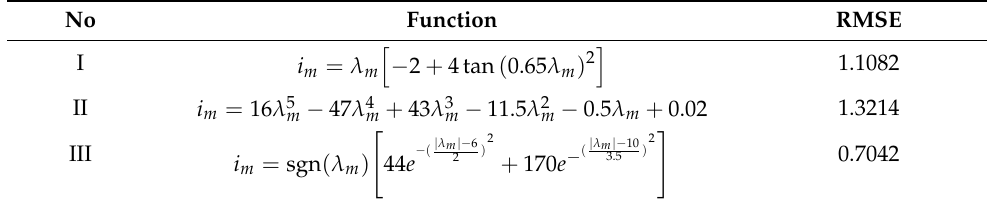
Table 1. Different functions used for the estimation of the magnetization curve of the transformer.